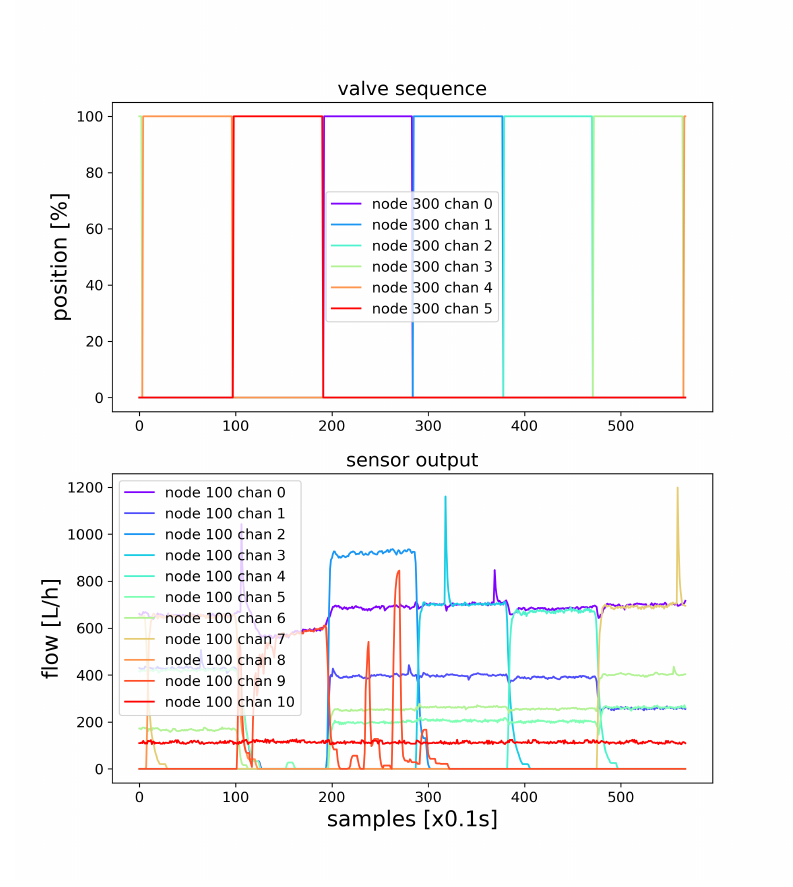
Figure 4. Experimental